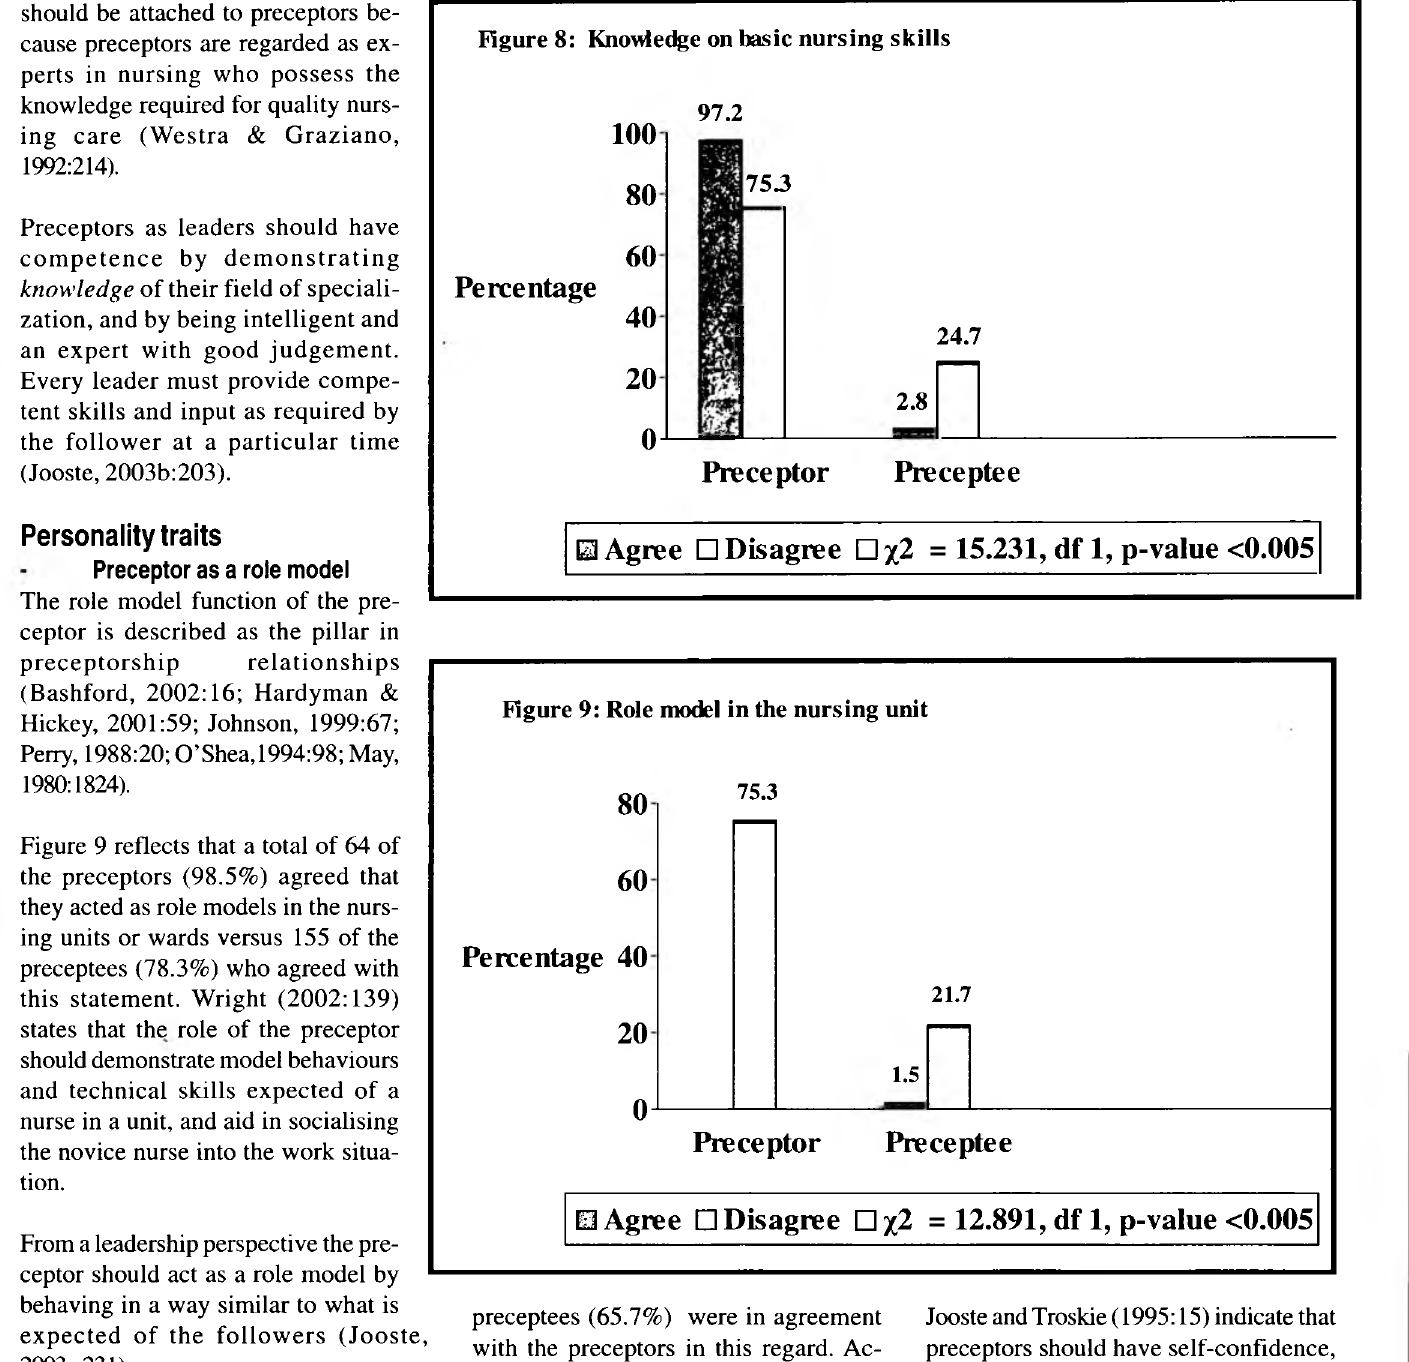
Figure 8: Knowledge on basic nursing skills